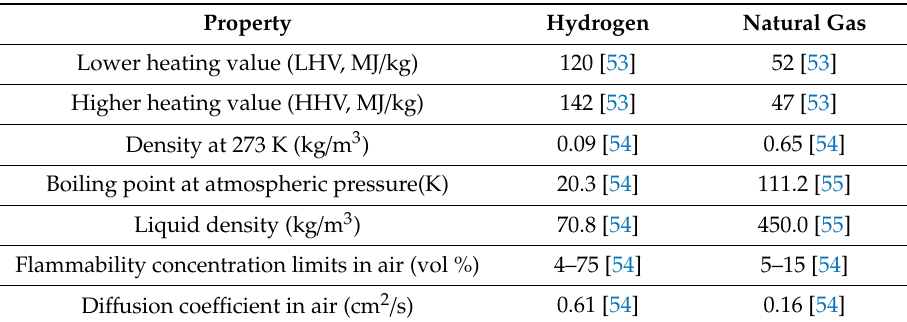
Table 1. Basic physico-chemical properties of hydrogen and natural